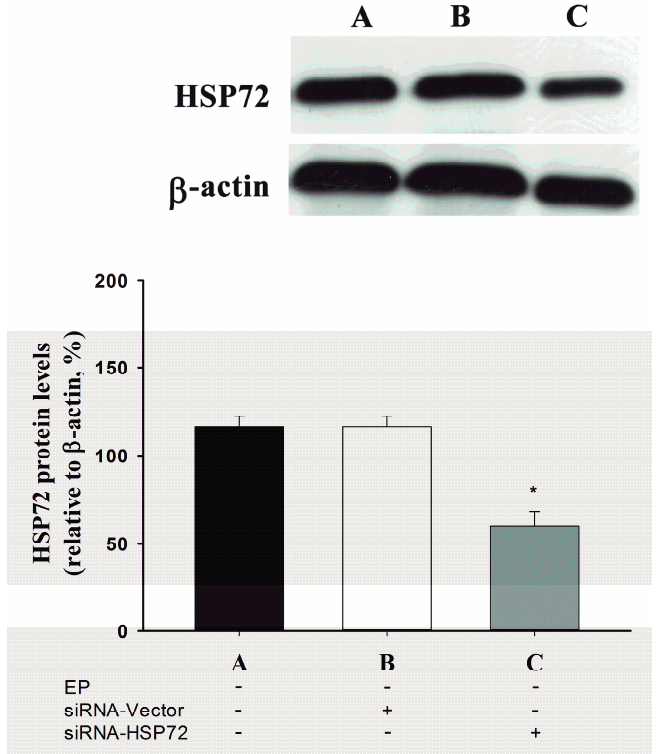
Figure 2. Effect of siRNA-HSP 72 on spinal cord expression of HSP 72 in different groups of rats. A: EP − control; B: EP − + siRNA-vector; C: EP − + siRNA-HSP 72. Spinal cord expression of HSP 72 was assessed by Western blot analysis 7 days after injection in sham groups of rats with no exercise-preconditioning. The gels presented are representative of results from three separate experiments. Densitometry readings of gel bands represent mean ± SD of three separate experiments. * p < 0.05 for A vs.